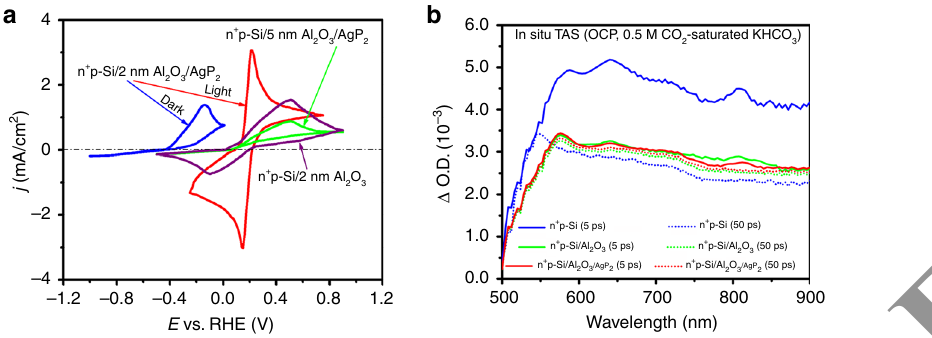
Fig. 5 Detailed characterization of photoelectrochemical response. a Cyclic voltammogram of n + p-Si/2 nm Al 2 O 3 , n + p-Si/2 nm Al 2 O 3 /AgP 2 , and n + p-Si/ 5 nm Al 2 O 3 /AgP 2 in ferri/ferrocyanide redox solution. All measurements were conducted in the simulated light illumination except as marked. b In situ transient absorption spectra of as-prepared samples measured in CO 2 -saturated 0.5 M KHCO 3 solution under open-circuit potential. The samples were excited by 450 nm laser with a power of 50 µ